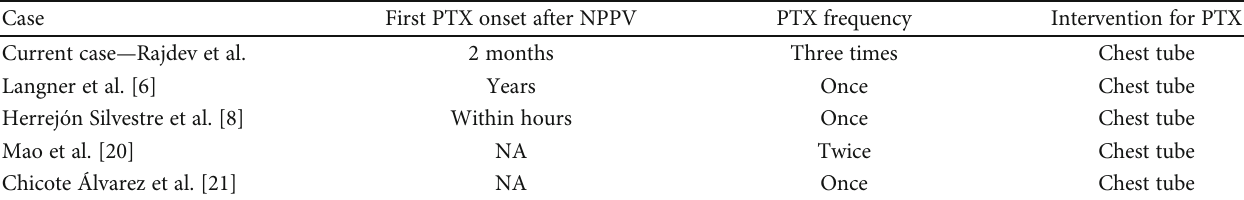
Table 2: Features of PTX in the a ff ected